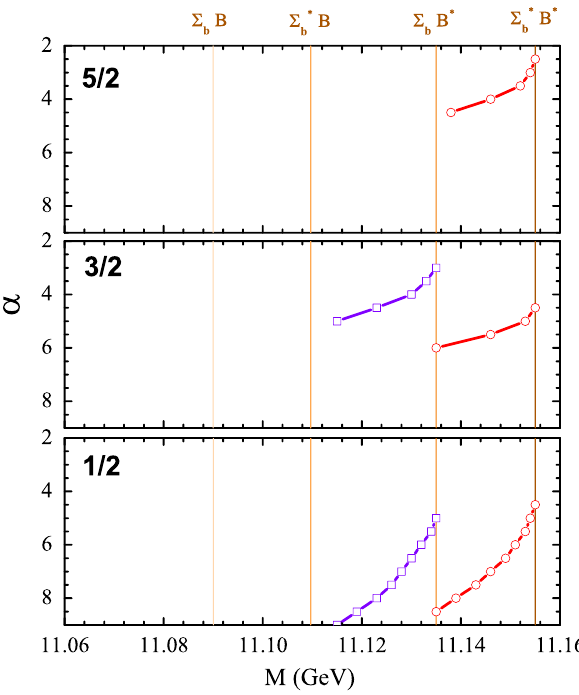
Fig. 2 The mass M with the variation of the α for isoquartet bound states. Other conventions are the same as in Fig. 1